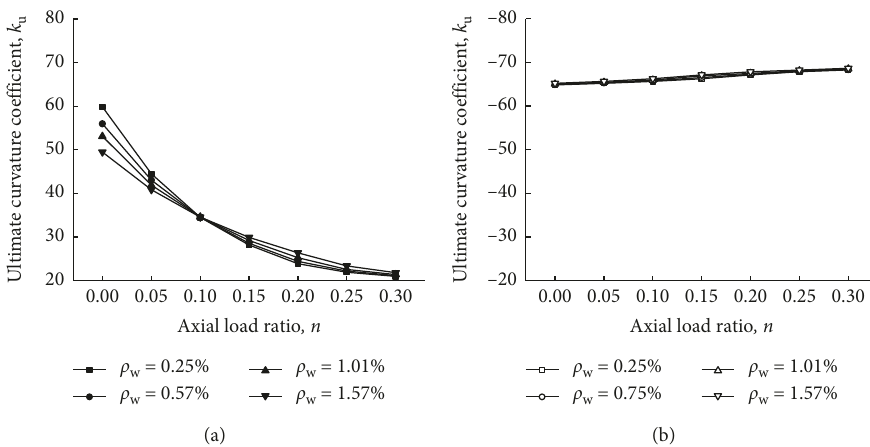
Figure 14: Variations in the ultimate curvature coefficient with the axial load ratio at different web distributed vertical reinforcement ratios. (a) Flange in tension. (b) Flange in